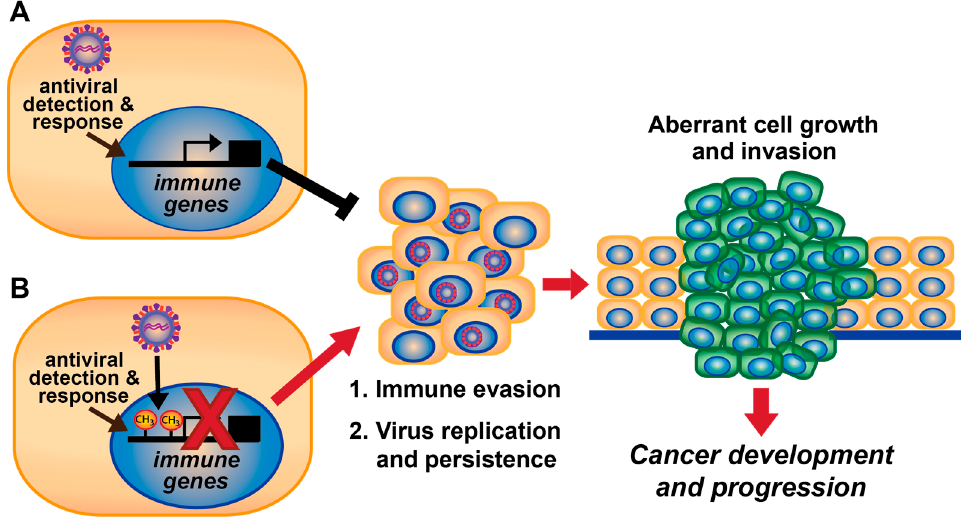
Figure 1. Model for DNA tumor virus-mediated DNA methylation to evade antiviral and antitumor immunity during viral persistence and carcinogenesis. ( A ) Cellular detection of viruses activates immune gene expression to induce an antiviral immune response. Proliferation of infected and neighboring cells can be blocked (black T bar) by immune-mediated apoptosis and/or cell cycle inhibition, which prevent cancer development. ( B ) DNA tumor viruses induce hypermethylation of immune genes that inhibit expression of antiviral immune genes (denoted by red “ × ”), resulting in immune evasion, which promotes (long red arrow) viral replication and persistence. Over long periods of time (multiple years), immune evasion and viral persistence can promote (short red arrow) cell proliferation and carcinogenesis. In addition, downregulation of immune gene expression by viral-induced DNA methylation may also contribute to host cell evasion of antitumor immune responses.